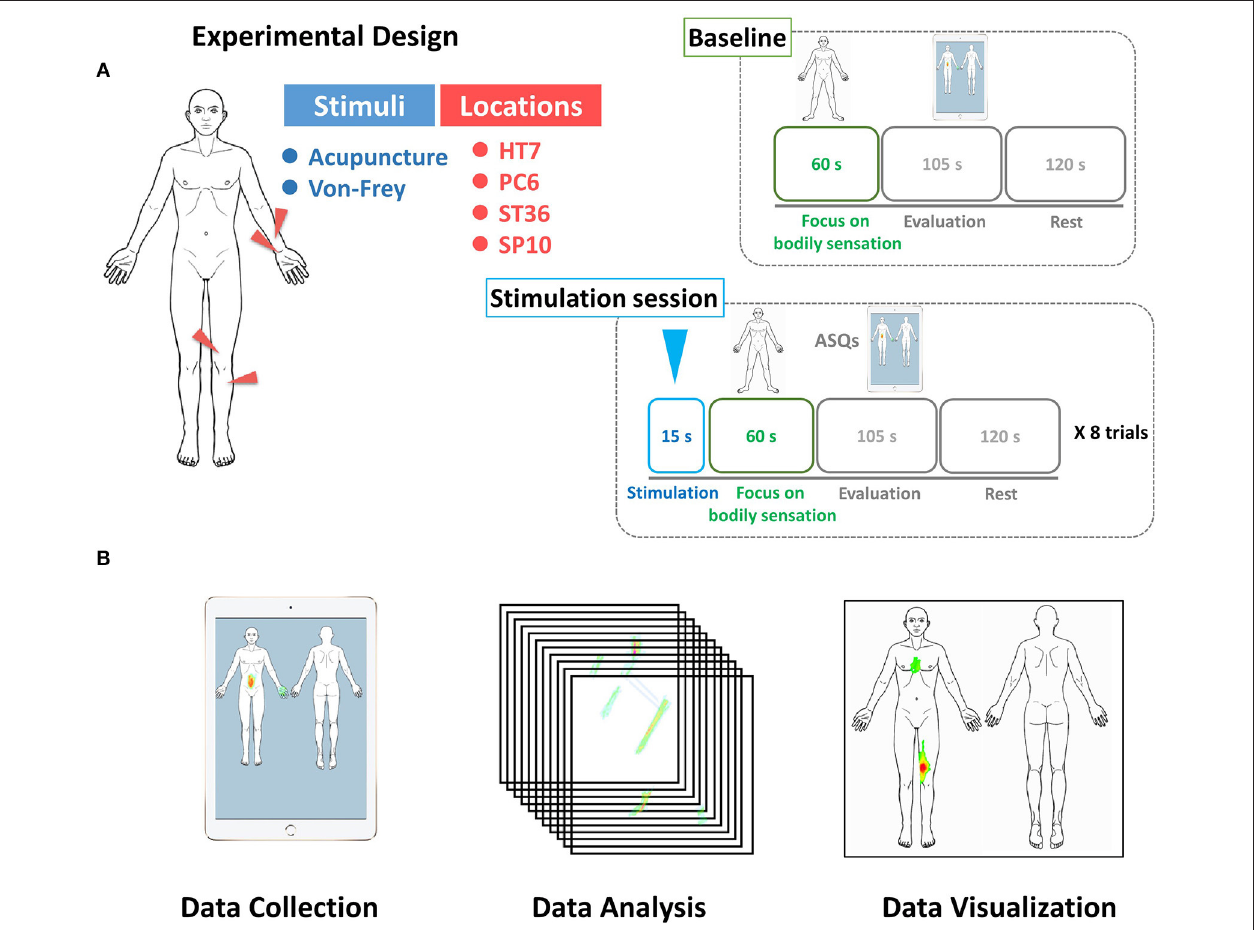
FIGURE 1 | (A) Experimental design. All participants received acupuncture or tactile stimulation at four different points (HT7, PC6, ST36, and SP10) on their left side. In each session, they were asked to evaluate the characteristics of DeQi sensations from the body and to mark the areas of the acupuncture-induced sensations using the BSM device. (B) Participants were asked to draw their bodily sensations using the BSM system. The BSM system was used to gather spatial information on the acupuncture sensations (Data collection). We calculated the statistical significance of associations between each condition and the spatial configuration of the acupuncture-induced sensations (Data analysis). We visualized the spatial distribution of acupuncture-induced sensations using the human body template by applying Z scores (Data